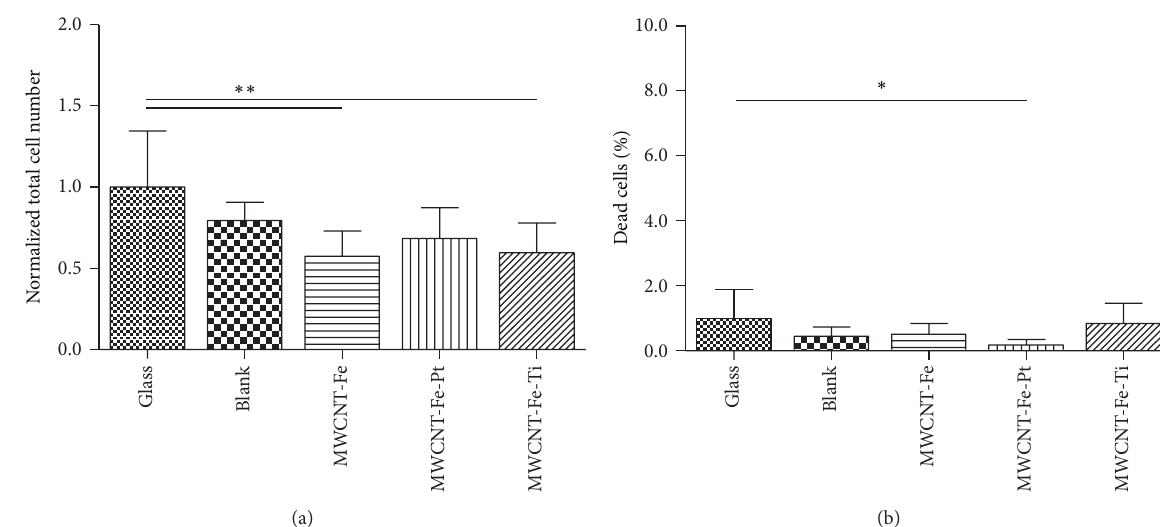
Figure 4: Effects of direct contact on viability of R28 cells. Cells were plated on a glass substrate and on the blank, MWCNT-Fe, MWCNT- Fe-Pt, and MWCNT-Fe-Ti wafer slices ( 𝑛 = 2 individual experiments), stained using FDA/PI, and counted 72 hours after seeding. For each substrate, 8 randomly selected microscopic fields were analyzed. Data are represented as mean ± SD. They were compared to the glass control and analyzed using unpaired two-tailed 𝑡 test. (a) The total cell numbers were normalized to the respective glass control. ∗∗ 𝑃 = 0.0077 , MWCNT-Fe; ∗∗ 𝑃 = 0.0093 , MWCNT-Fe-Ti. (b) The quantity of dead cells is shown as a percentage of the corresponding total cell number. ∗ 𝑃 = 0.0322 ,